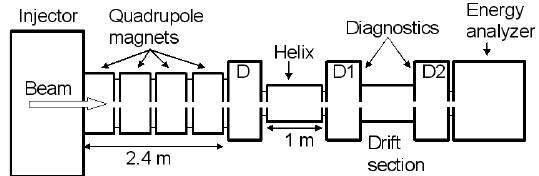
FIG. 3. Experimental configuration of the PLIA with a K (cid:2) beam injector, transported by four pulsed quadrupole magnets, 1 m long helix section, diagnostics, and an electrostatic energy